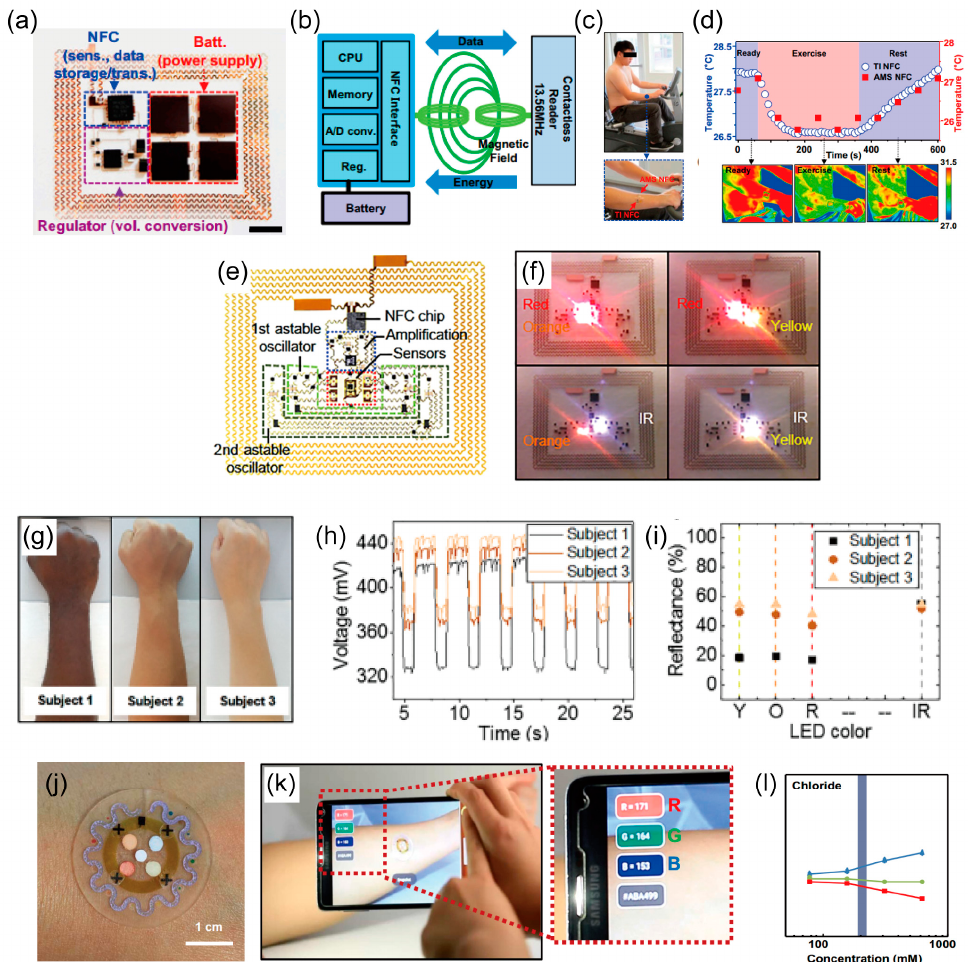
Figure 10. Near field communication (NFC)-enabled wearable sensor. ( a ) Image of the NFC-enabled wearable sensor system composed of the NFC devices, batteries, and a power regulator. Scale bar, 5 mm; ( b ) Schematic illustration of the entire operation system; ( c ) Photo images of the NFC-enabled wearable sensor attached onto the human skin during exercise; ( d ) Temperature data and IR images at the stage of the before, during, and after exercise (which correspond to the “ready”, “exercise”, “rest”) recorded by using NFC-enabled wearable sensor with a battery module (AMS NFC, red squares) and with the battery-integrated system (TI NFC, open circle). ( a – d ) Reproduced with permission from Ref. [176]. Copyright 2016, National Academy of Sciences; ( e ) Image of a NFC-enabled wearable sensor system including four pulsed LEDs (red, IR, orange, and yellow), two oscillators, amplifier and sensors; ( f ) Photo images of the NFC-enabled wearable sensor system during operation; ( g ) Images of subjects with different skin colors; ( h , i ) Wirelessly measured data and calculated reflectance value of the different skin colors. ( e – i ) Reproduced with permission from Ref. [157]. Copyright 2016, American Association for the Advancement of Science; ( j ) Optical image of a fabricated device mounted on the forearm; ( k ) Pictures demonstrating NFC between a sweat monitoring device and a smartphone to launch software for image capture and analysis; ( l ) Standard calibration curves between normalized %RGB value and concentration of markers for quantitative analysis (error bars show s.d. ( N = 3)). ( j – l ) Reproduced with permission from Ref. [177]. Copyright 2016, American Association for the Advancement of Science.